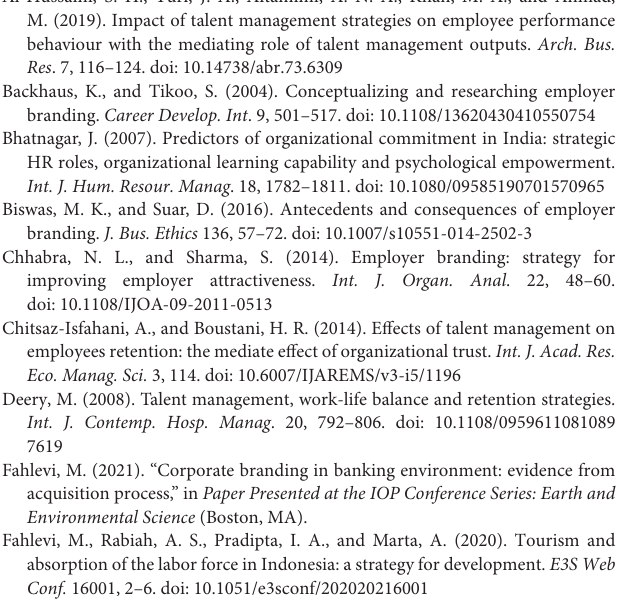
Figurska, I., and Matuska, E. (2013). Employer branding as a human resources management strategy. Hum. Resour. Manag. Ergonom . 7, 35–51.